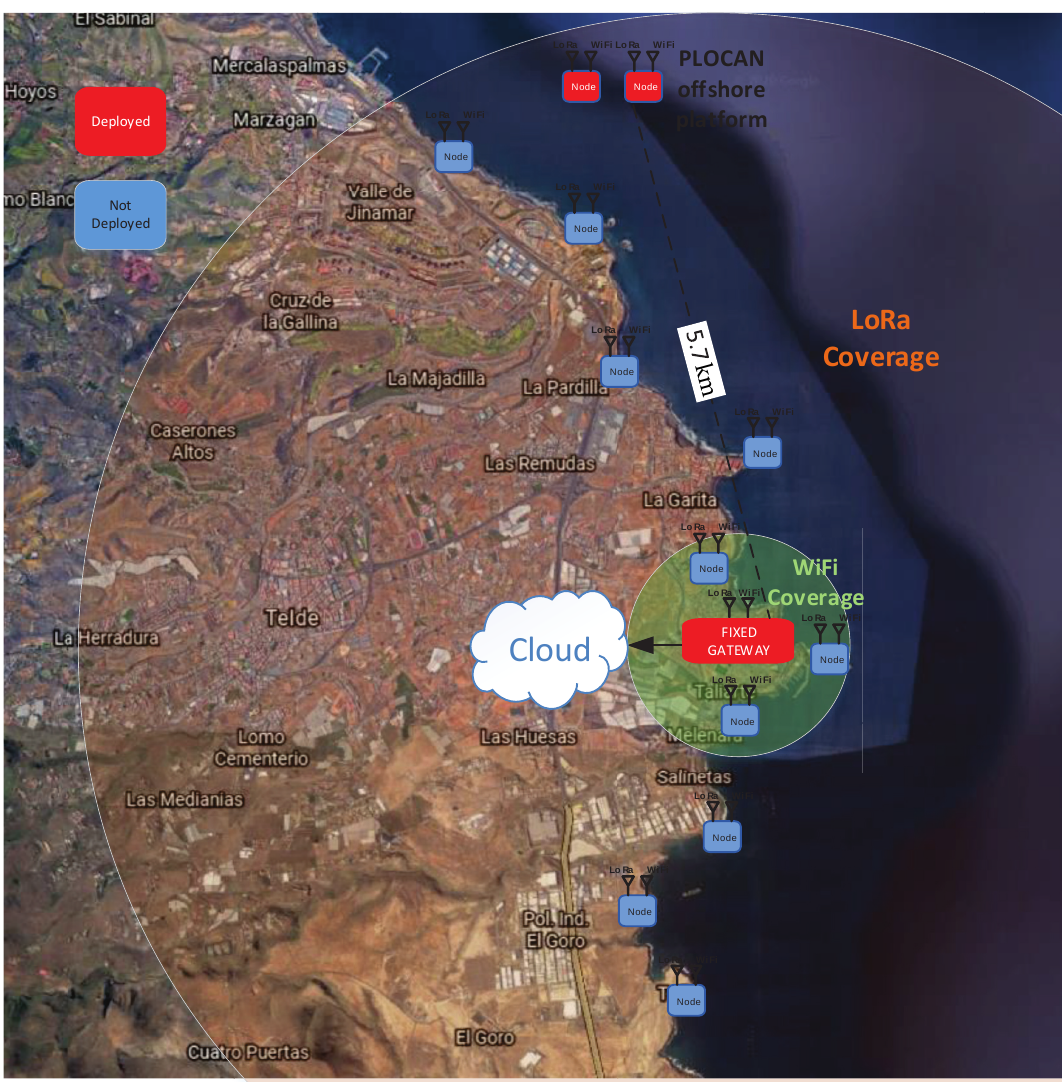
Figure 2. Proposed flexible Fog Computing